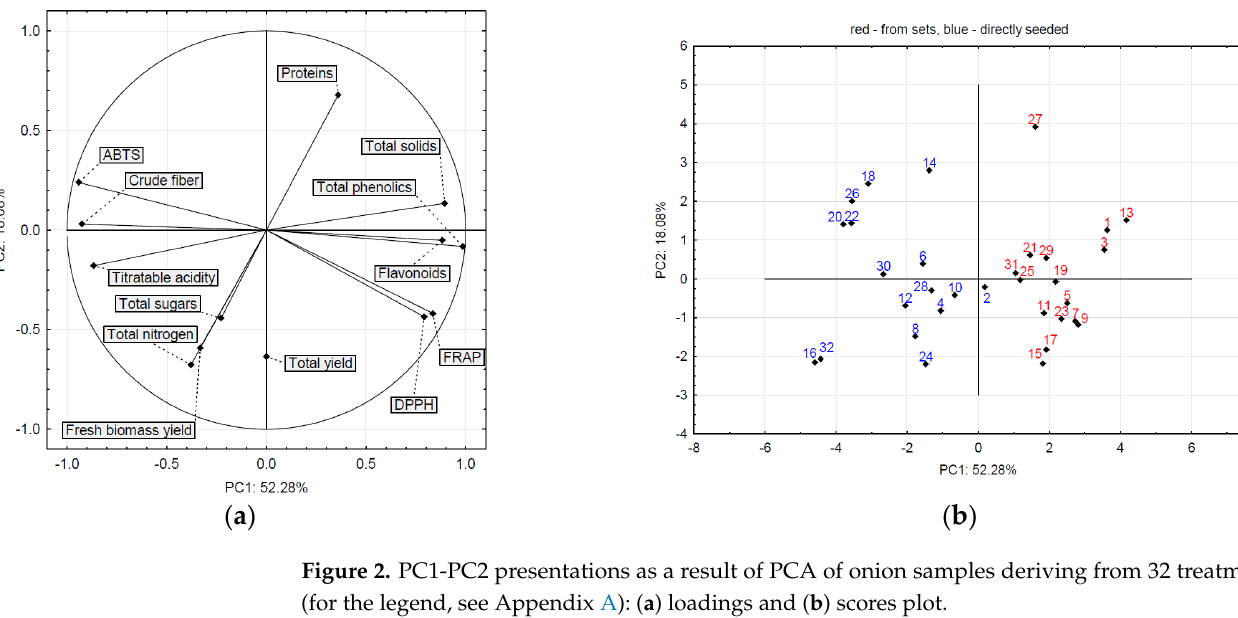
Figure 3. HCA analysis of all 32 onion samples deriving from 32 treatments (for the legend, see Appendix A). In order to conduct the detailed analysis of data from both cultivation methods, two data sets were formed, and again the min ‐ max normalization procedure was performed. The first data set consisted of samples of DS onion deriving from 16 treatments, and the